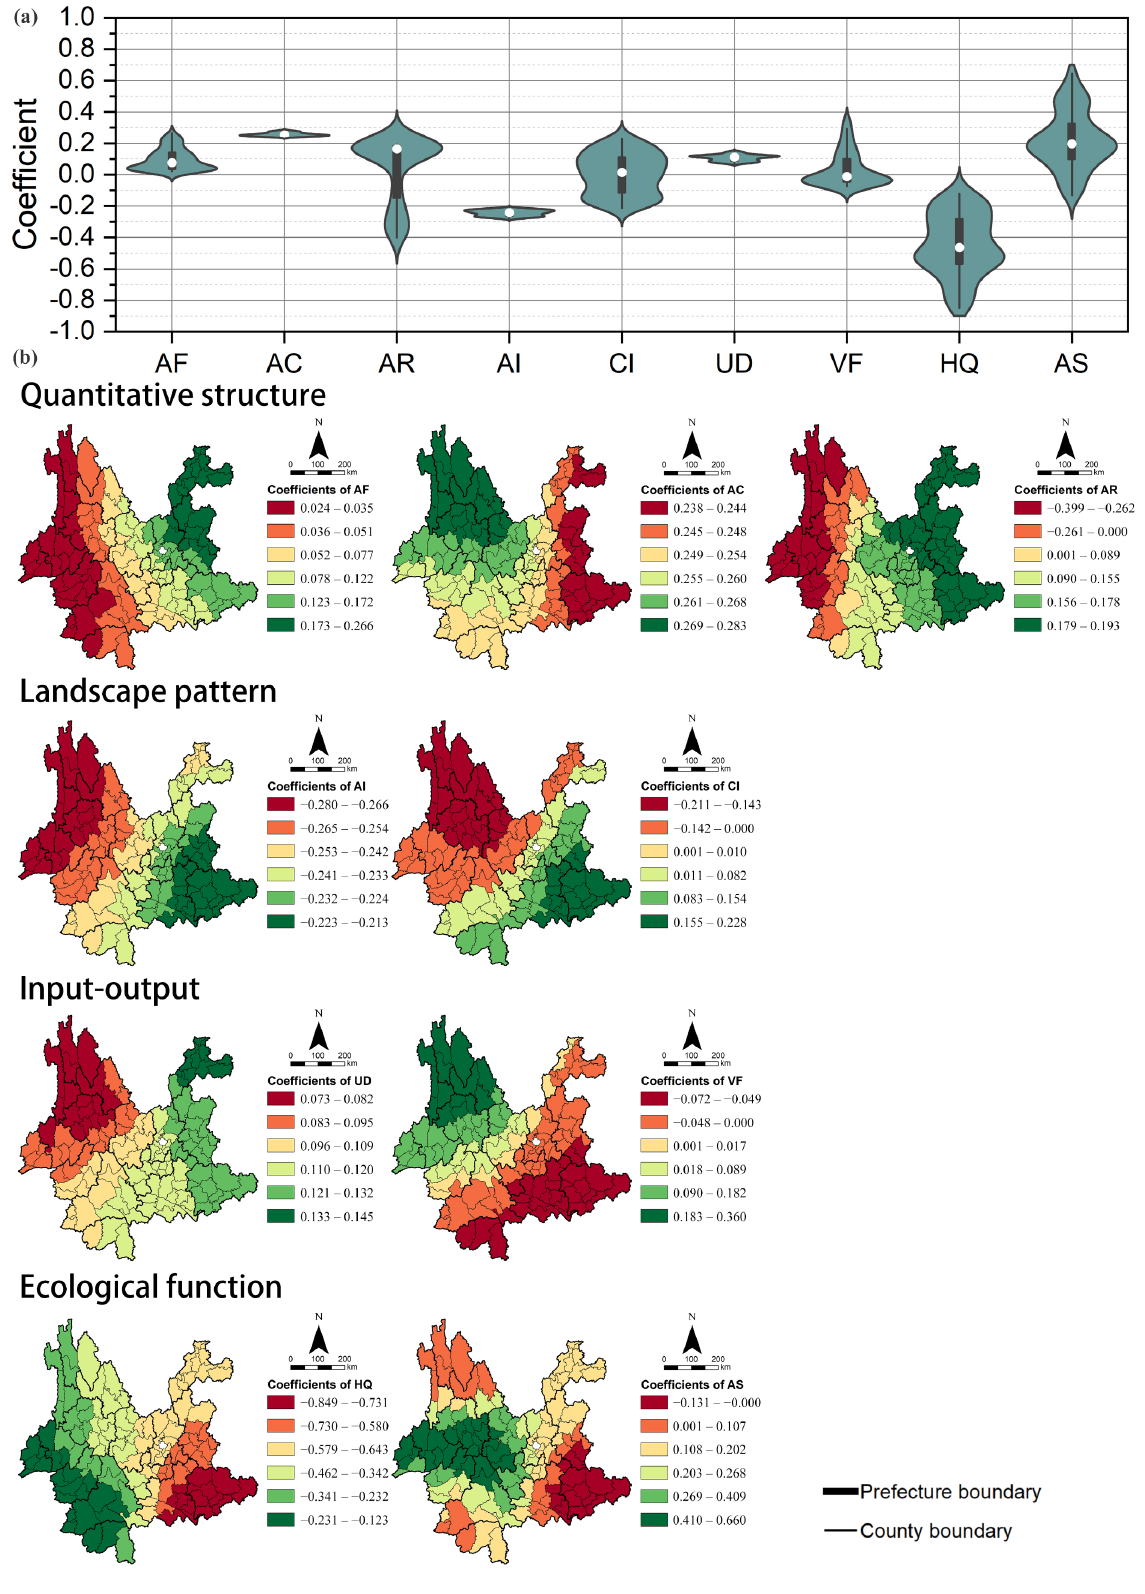
Figure 7. Coefficient distribution of each LUT factors in TPA. ( a ) Violin diagram of coefficient distribution. ( b ) Coefficient of the driving mechanism in space.